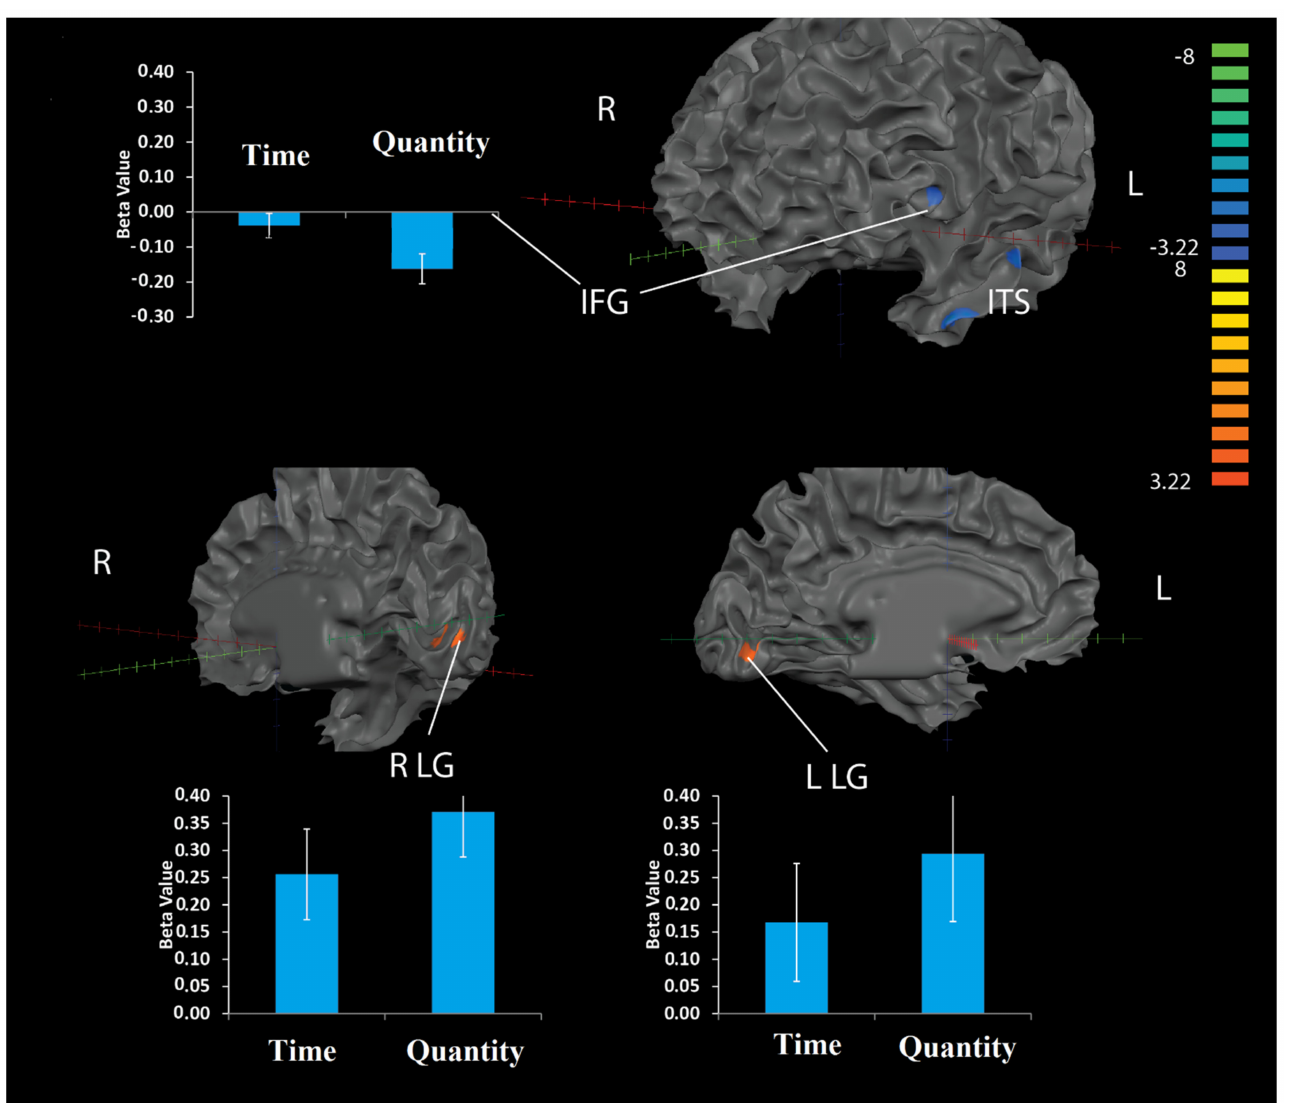
Figure 5. Brain activations related to CET numerical estimation > time. Illustrated are brain areas that showed differences between activity levels of numerical estimation compared to time estimation. Specifically, increased activation during numerical estimation was found in the left and right lingual gyrus (LG 14, − 82, − 2 and − 6, − 80, − 6). Increased deactivation during numerical estimation was found in the right inferior frontal gyrus (IFG) ( − 43, − 60, 19). Quantity = numerical